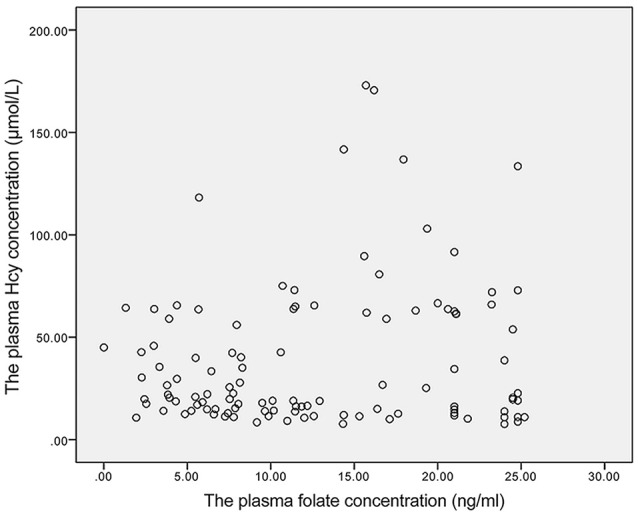
The linear correlation between homocysteine and folate concentrations. Homocysteine and folate concentrations did not exhibit a linear correlation (rs = 0.009, P = 0.924).